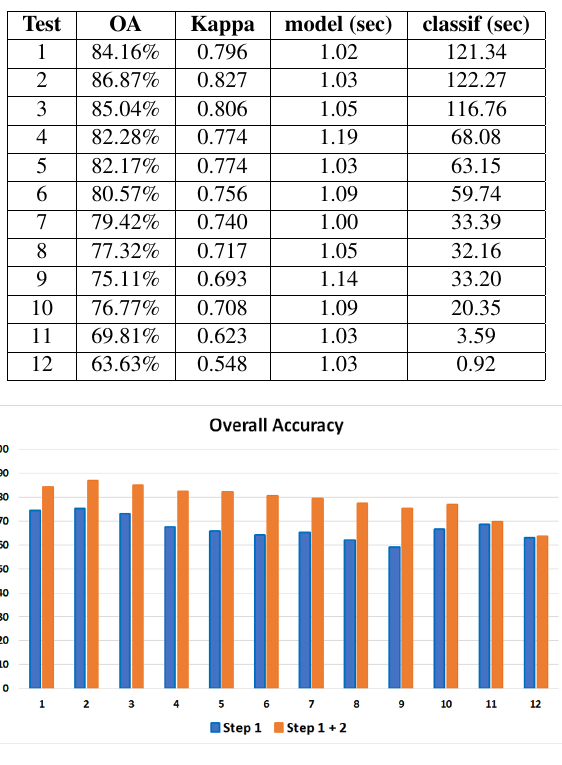
Figure 9. Overall Values